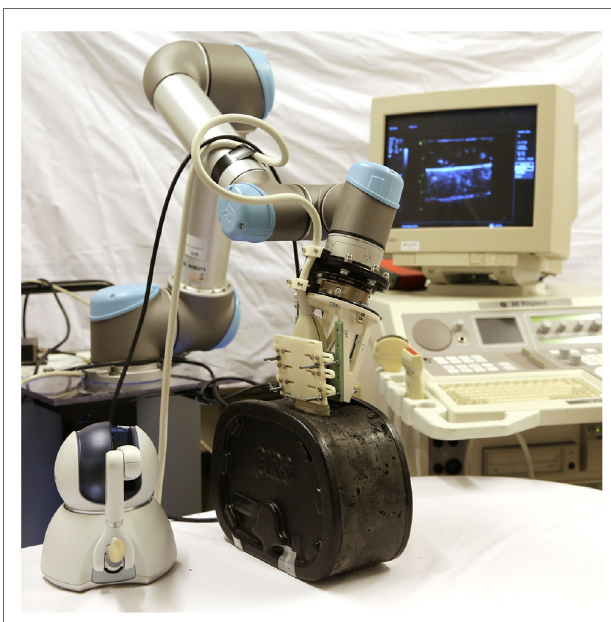
FigUre 2 | The developed robotic ultrasound system. To the lower left is the Phantom Omni haptic device. To the right is a GE System Five ultrasound machine, and in the center is the UR5 robot holding an ultrasound probe. The phantom is a Abdominal Phantom, Model 057 from